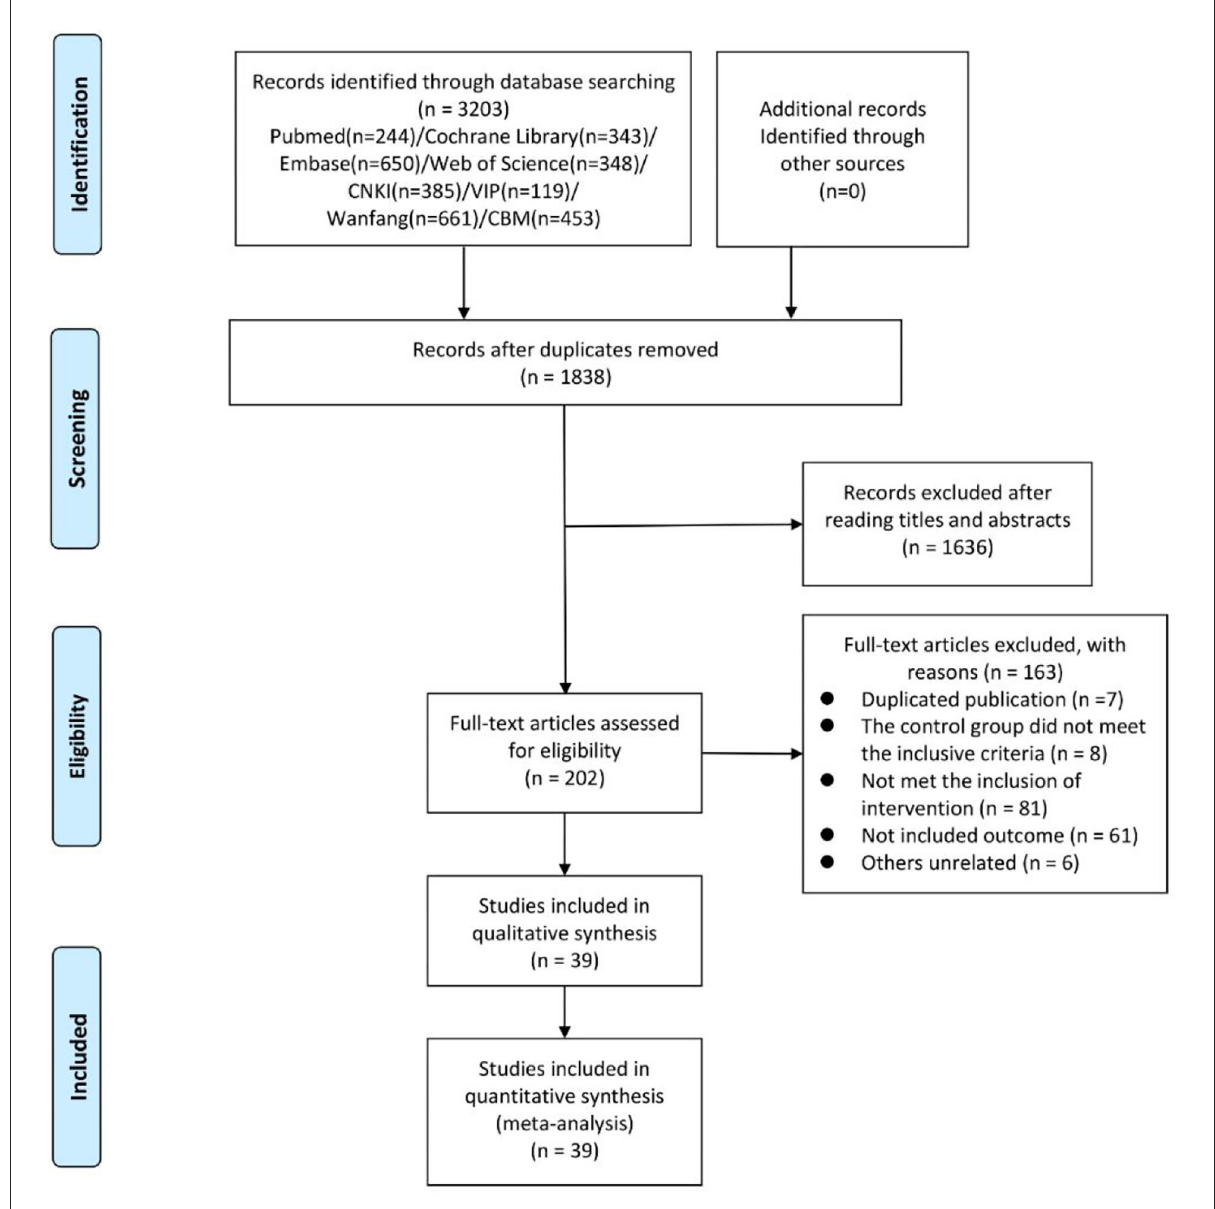
FIGURE1 Flow diagram depicting the study selection process (n, number of publications).